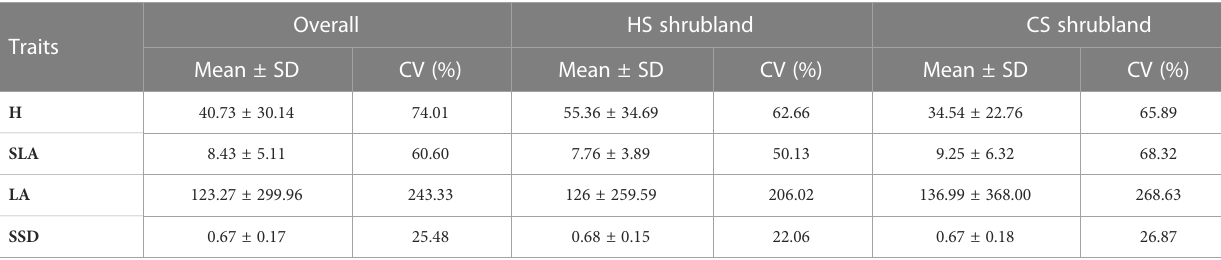
TABLE 1 Functional trait values for all species and shrubland types weighted values.